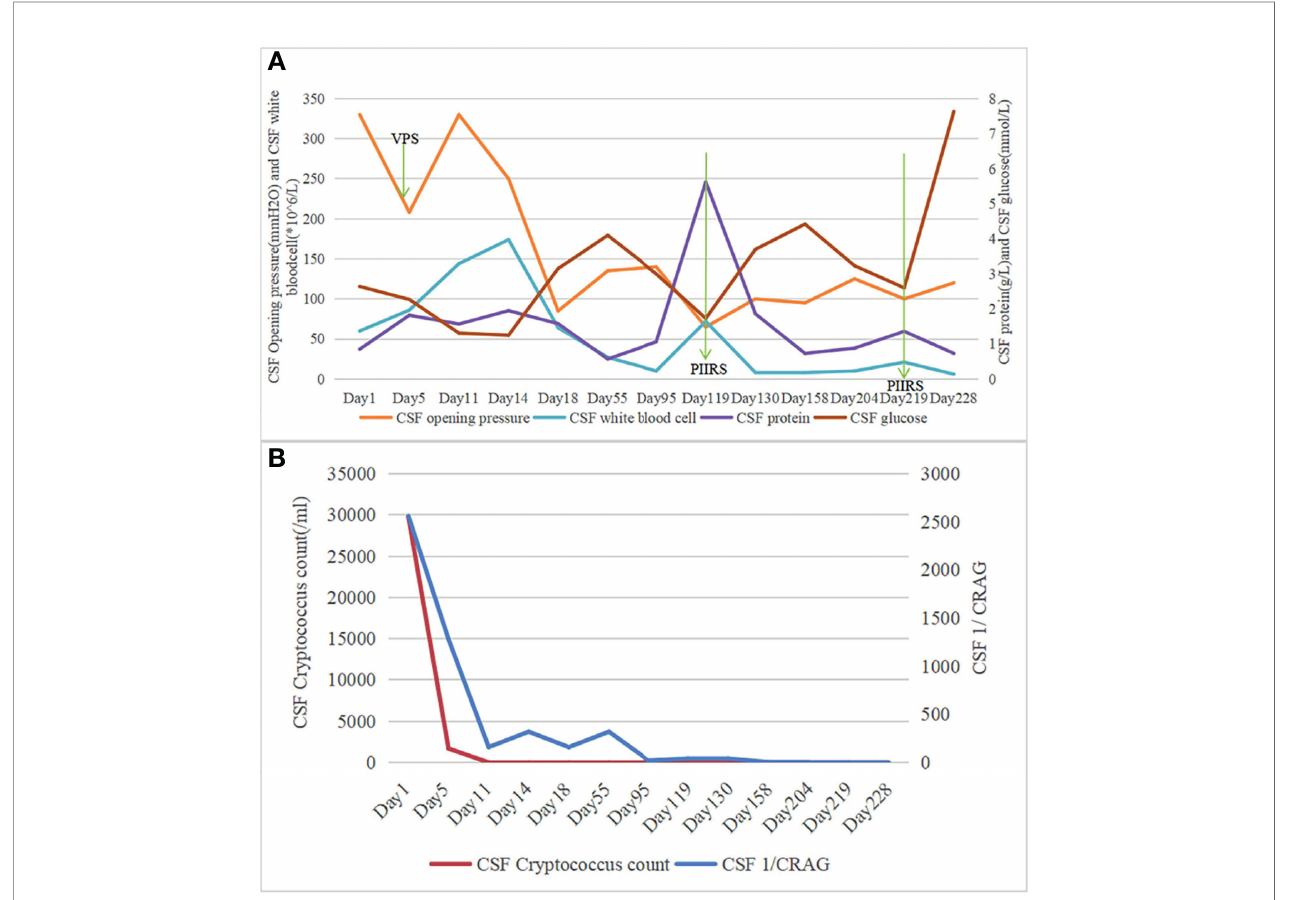
FIGURE 1 | (A) Chronologic representation of serial cerebrospinal fl uid (CSF) measurements obtained from lumbar puncture with CSF opening pressure and CSF white blood cell (WBC) count on the left axis and CSF protein, CSF glucose on the right axis. (B) Chronologic representation of serial CSF measurements obtained from lumbar puncture with CSF cryptococcus count on the left axis and CSF 1/CRAG on the right